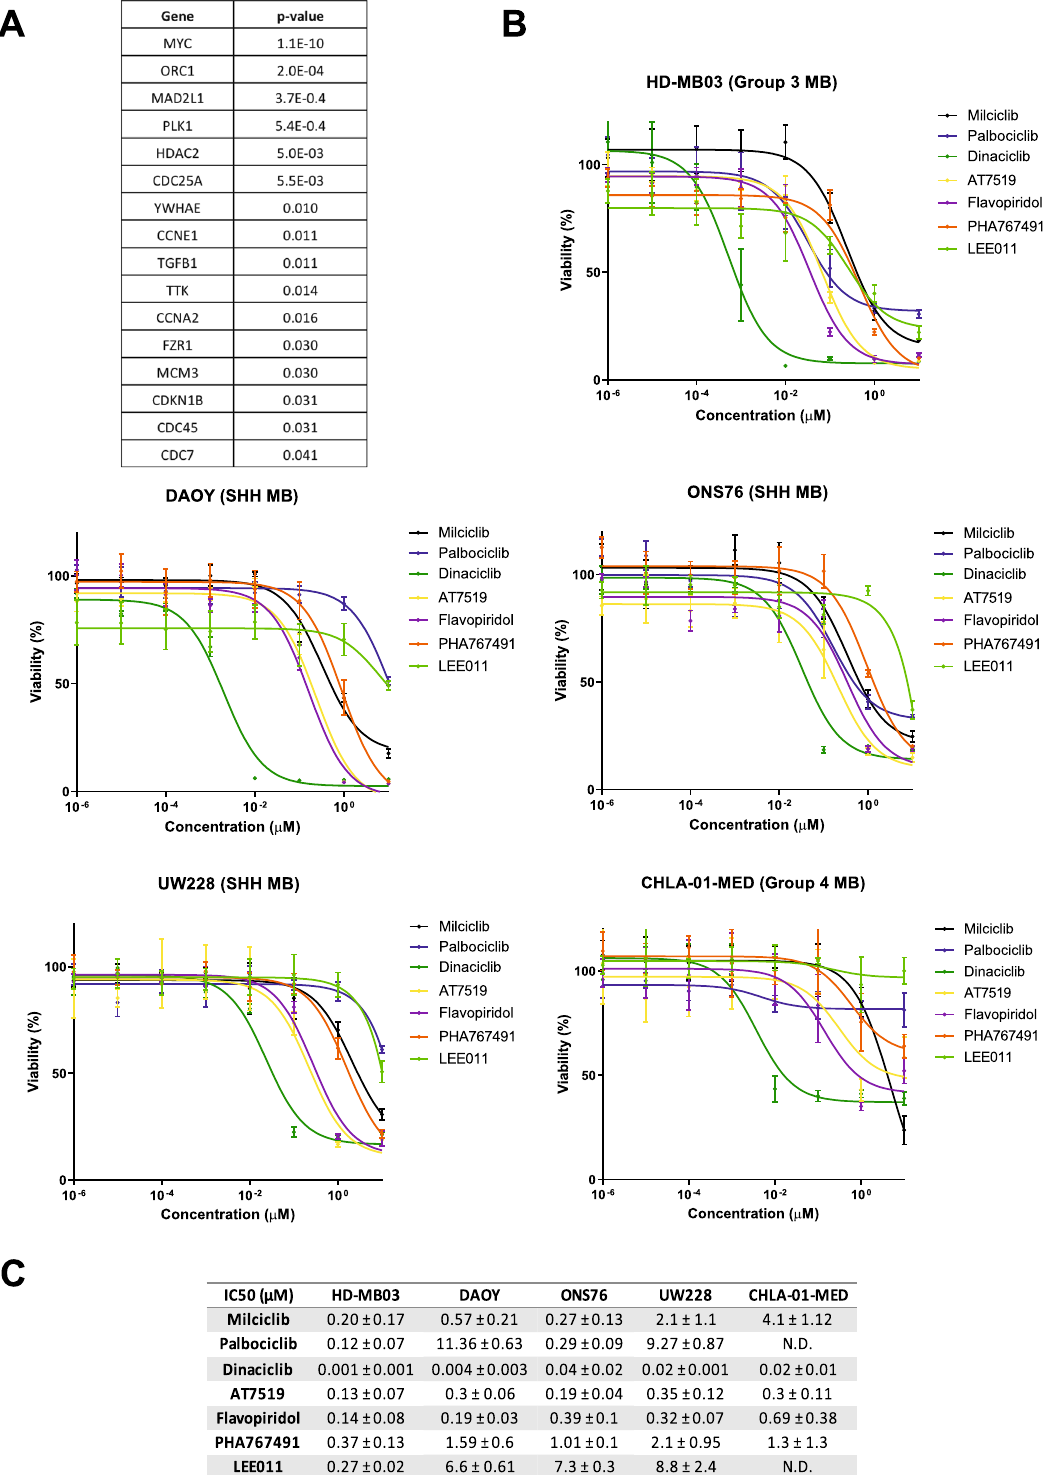
Figure 1. Screening of CDKis with different selectivity in medulloblastoma in vitro models. ( A ) Transcriptional data associated with the cell cycle gene set from 612 patients across the four MB subgroups (Cavalli et al. dataset). Results were corrected for multiple gene testing by FDR ( P value < 0.05). ( B ) Proliferation assay of indicated HD-MB03 (Group 3), DAOY (SHH), ONS76 (SHH), UW228 (SHH) and CHLA-01-MED (Group 4) cell lines treated with scalar concentrations (0–10 µM) of indicated CDKis for 72 h. Plotted graphs show mean ± SD (n = 3). ( C ) IC50 values of tested CDKis on medulloblastoma cell lines. IC50 values represent mean ± SD (n =